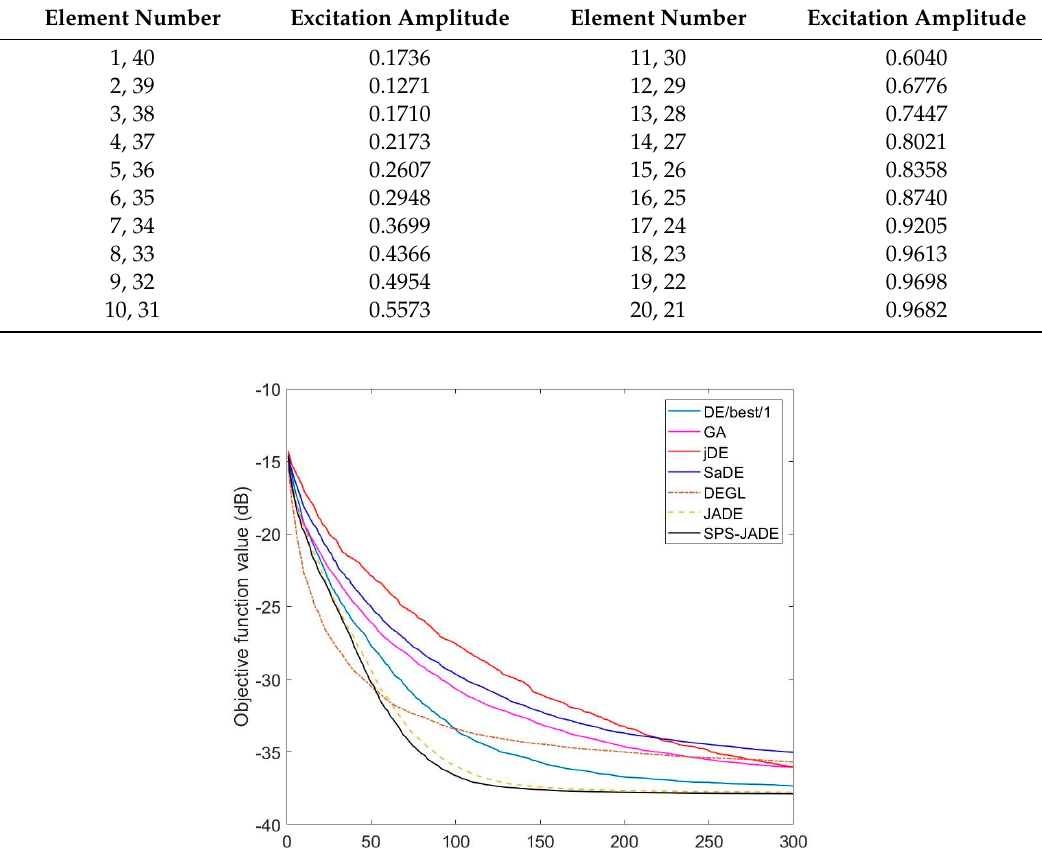
Figure 5. The optimal patterns with the null at θ = 24° for the linear antenna array. Table 6. The optimal excitation amplitudes of array elements computed by SPS-JADE algorithm with sidelobe suppression and null depth.